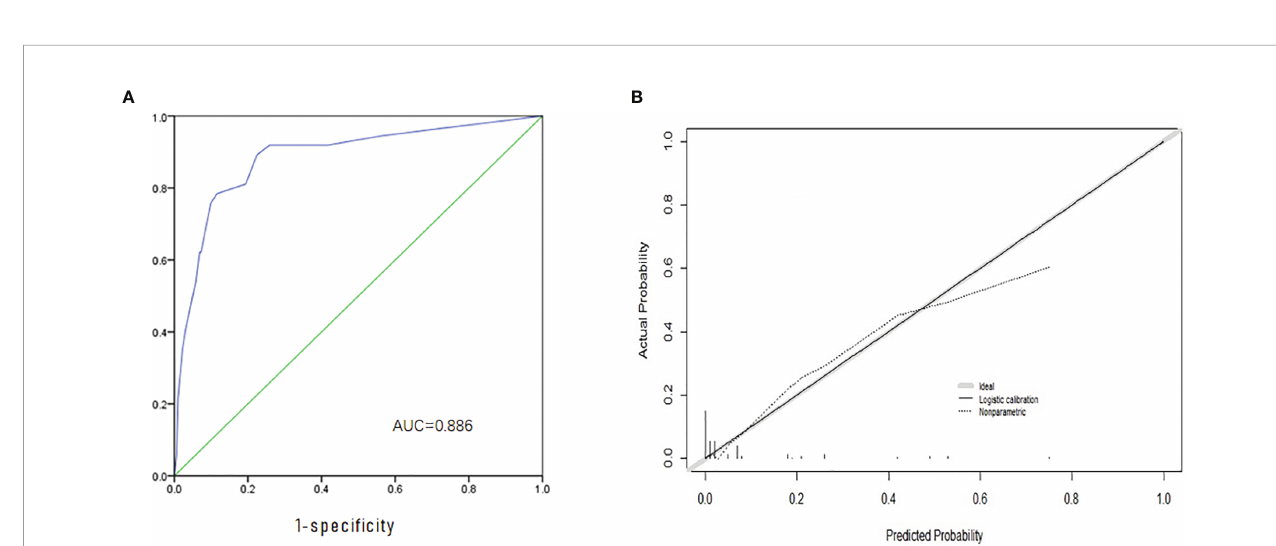
FIGURE 2 | Evaluation and Validation of the nomogram. (A) The ROC curve and AUC of the nomogram; ROC, receiver operating characteristics; (B) The calibration curve of the nomogram for predicting possible CNM. Actual probability is plotted on the y-axis, and nomogram predicted probability on the x-axis.